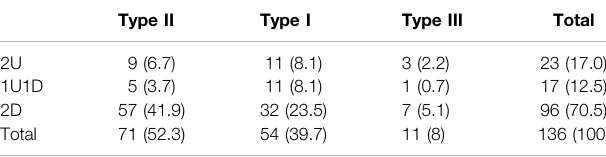
TABLE 2 | Numbers (%) of patients in each subtype/mutations group.